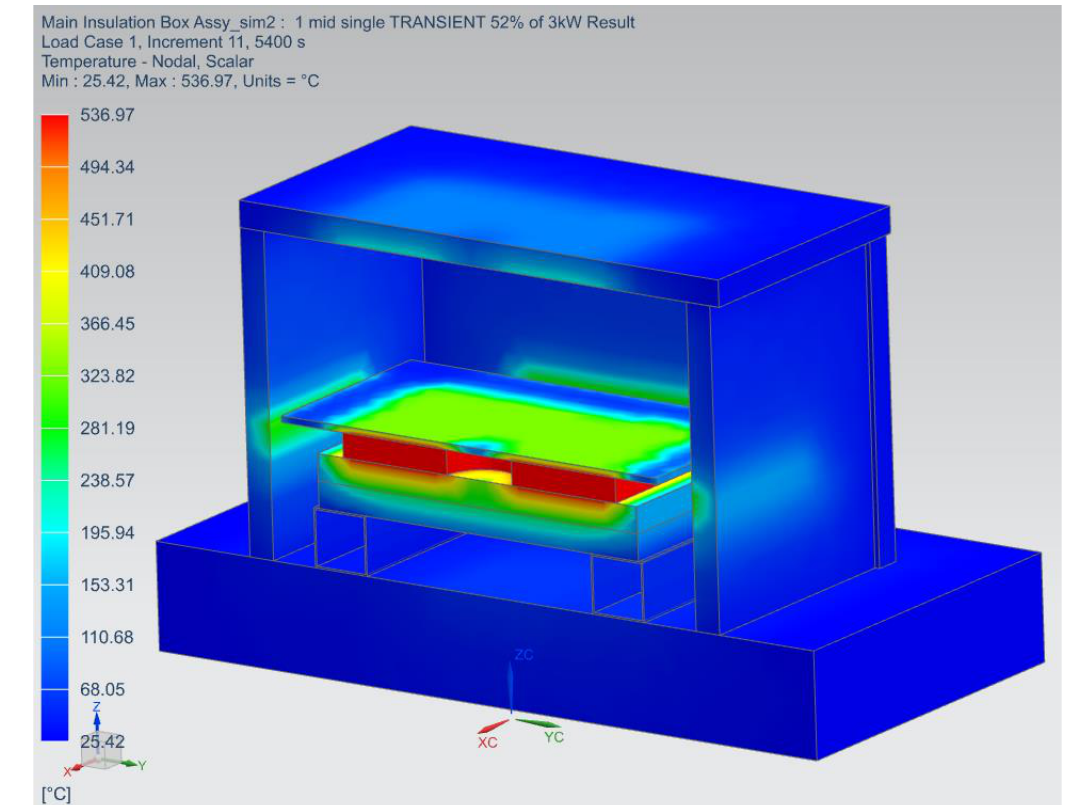
Figure 21. Current insulation material thermal analysis results.